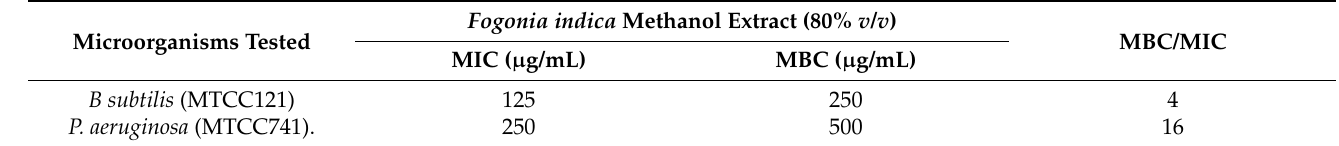
Table 6. Determination of MIC, MBC and MBC/MIC ratios of Fogonia indica methanol extract against the selected